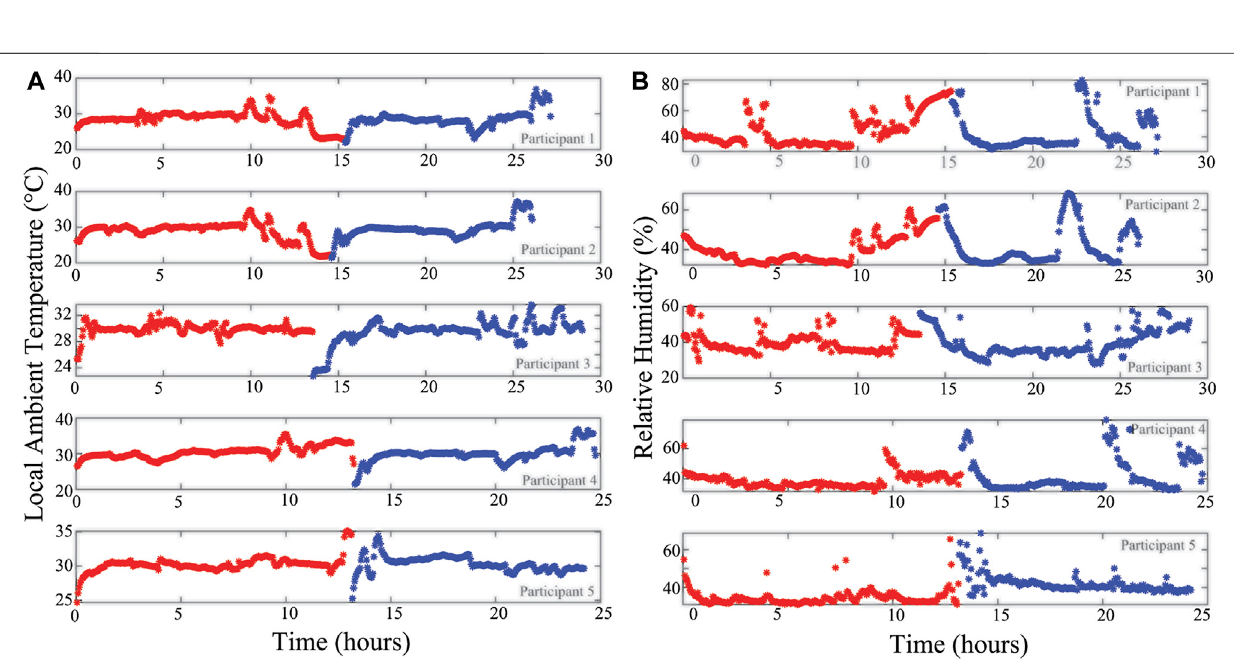
FIGURE 10 | (A) Temperature and (B) relative humidity of local wearable environment across day 1 (red) and 2 (blue) of participant data collection.